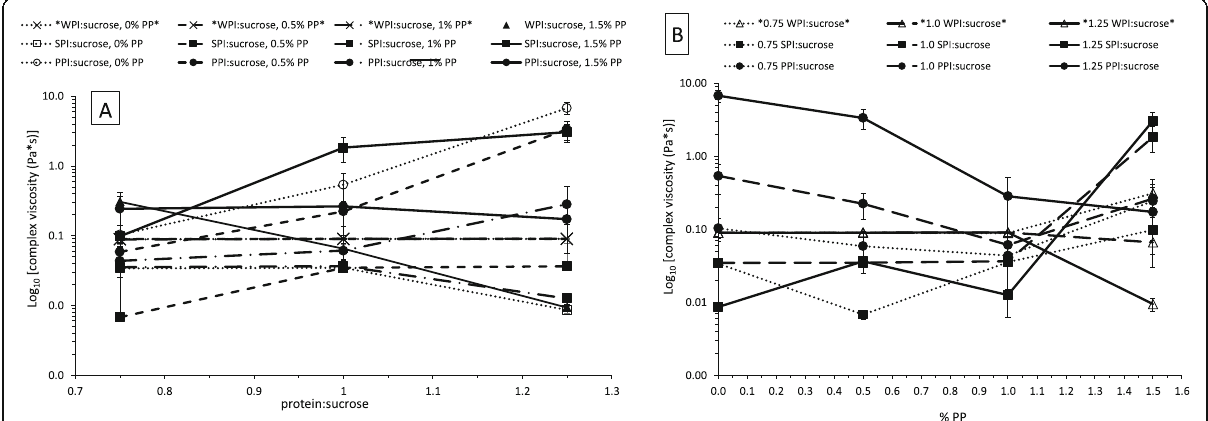
Fig. 3 Effect of protein:sucrose ratio ( A ) and PP content (%) ( B ) on the complex viscosity (Pa*s) of dispersions at 25 °C; (averaged data plotted, n = 9). Legend entries marked * contain data points reported in previous work (Hansen et al., 2021a; averaged data plotted, n = 6). Lines are for guiding purposes